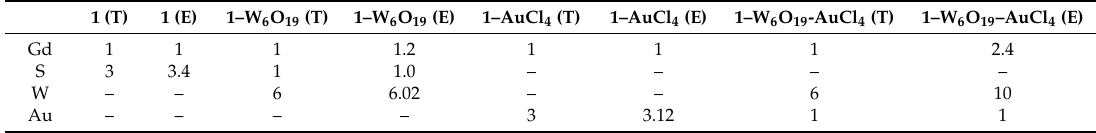
Table 3. Ratio determination for Gd, S, W, Au by EDAX (T: Theoretical, E: